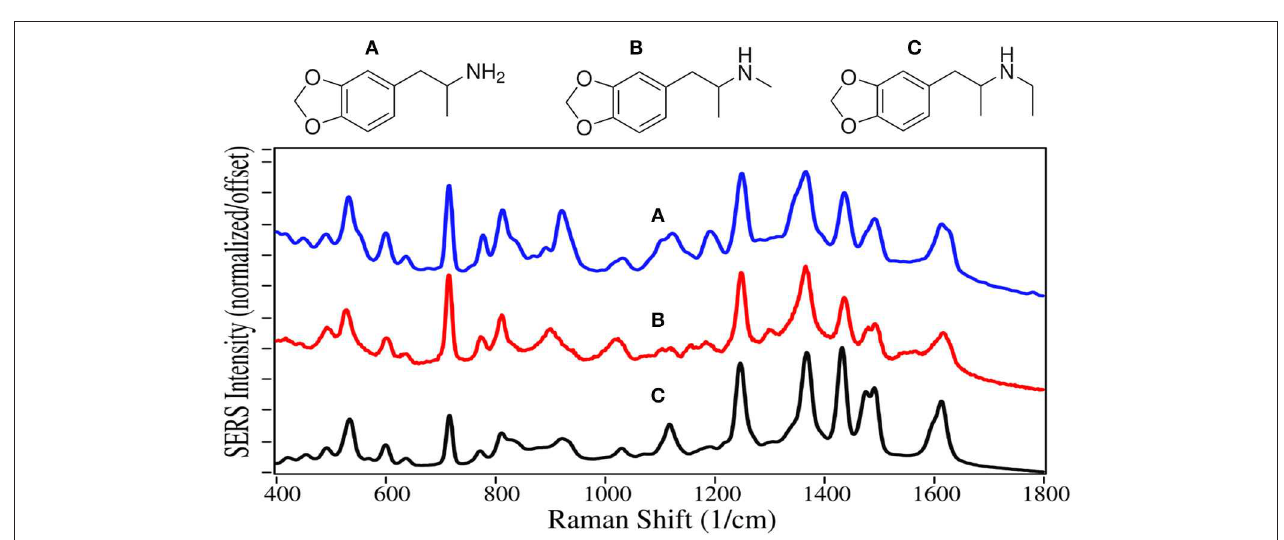
FIGURE 9 | Structures and 100 ppm SERS of (A) MDA, (B) MDMA, and (C)